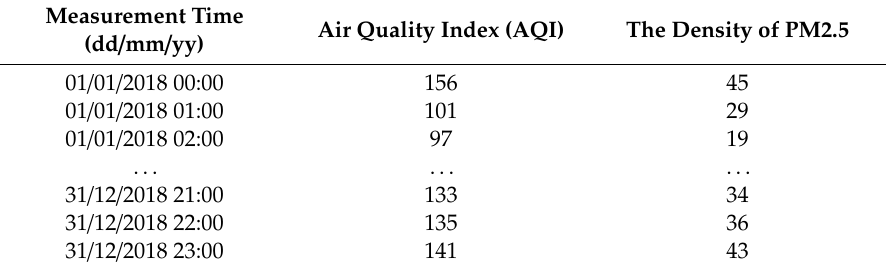
Table 6. An example of a data table in a time series database